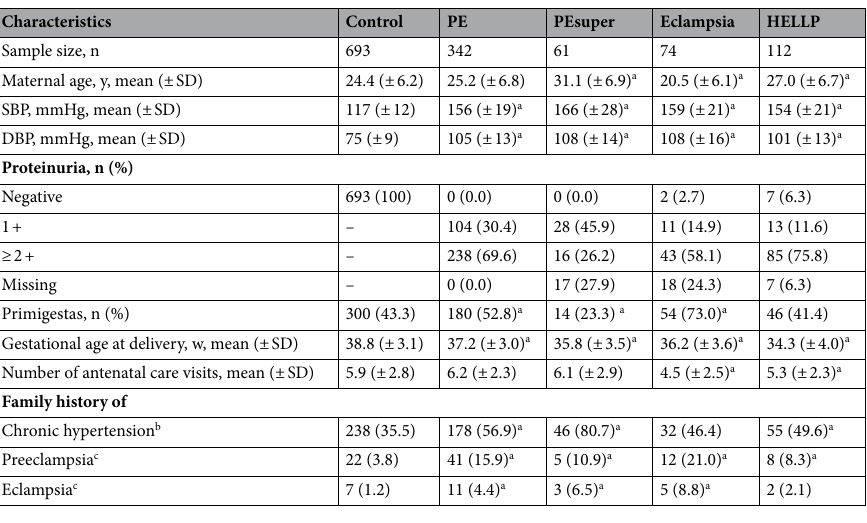
Table 1. Demographics and clinical characteristics. SBP/DBP systolic blood pressure/diastolic blood pressure. PEsuper : chronic hypertension with superimposed preeclampsia. a p < 0.05 for comparison with the control group. b If at least one first degree relative has the disease. c If the mother had had the